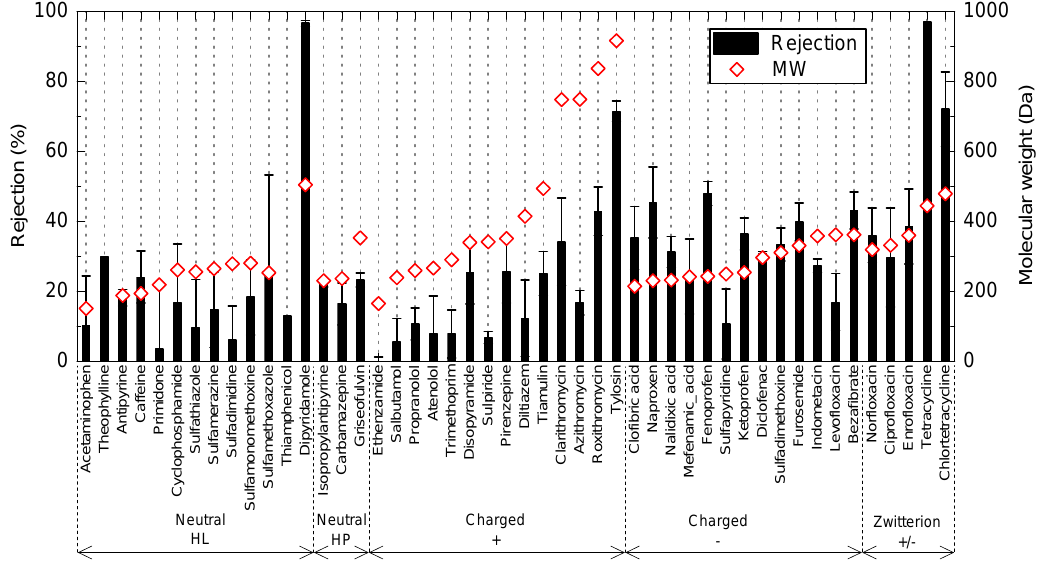
Figure 3. Rejection of PPCPs by the ceramic NF membrane during NF filtration of the secondary wastewater effluent. Values and error bars are the average and standard deviation of two replicate samples.